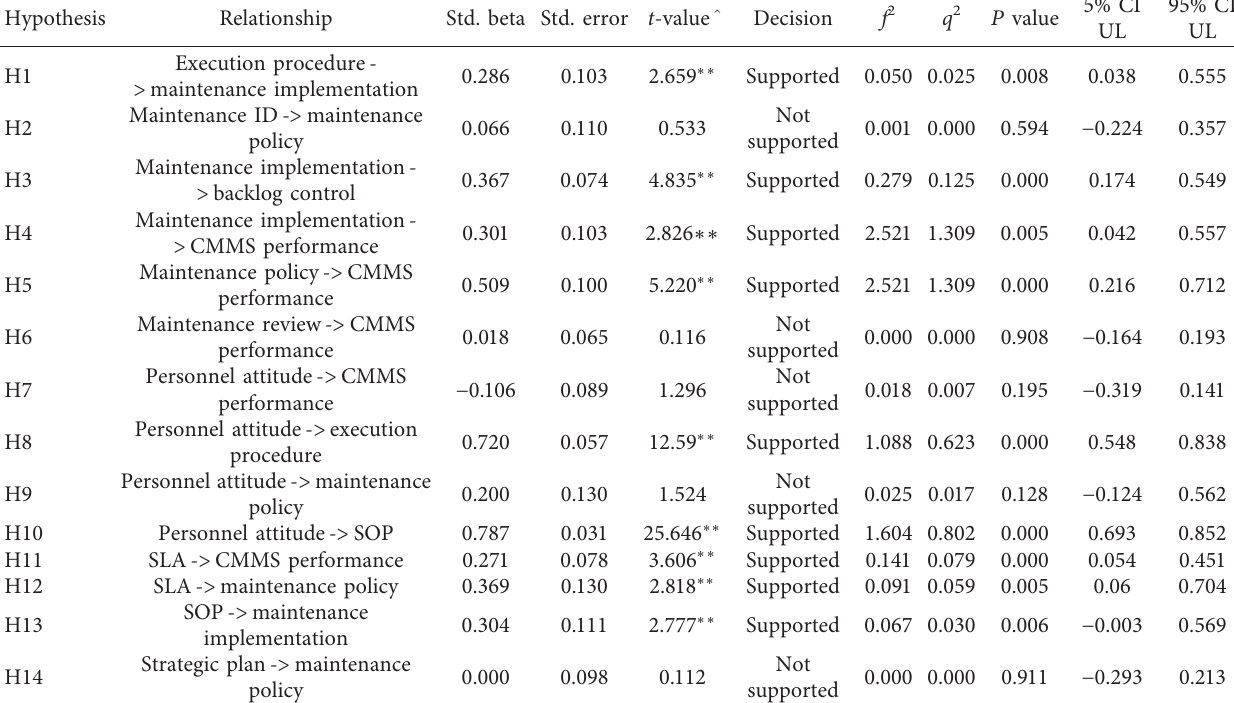
Figure 6: R 2 absolute values of CMMS performance model. Table 3: Direct relationship for hypothesis